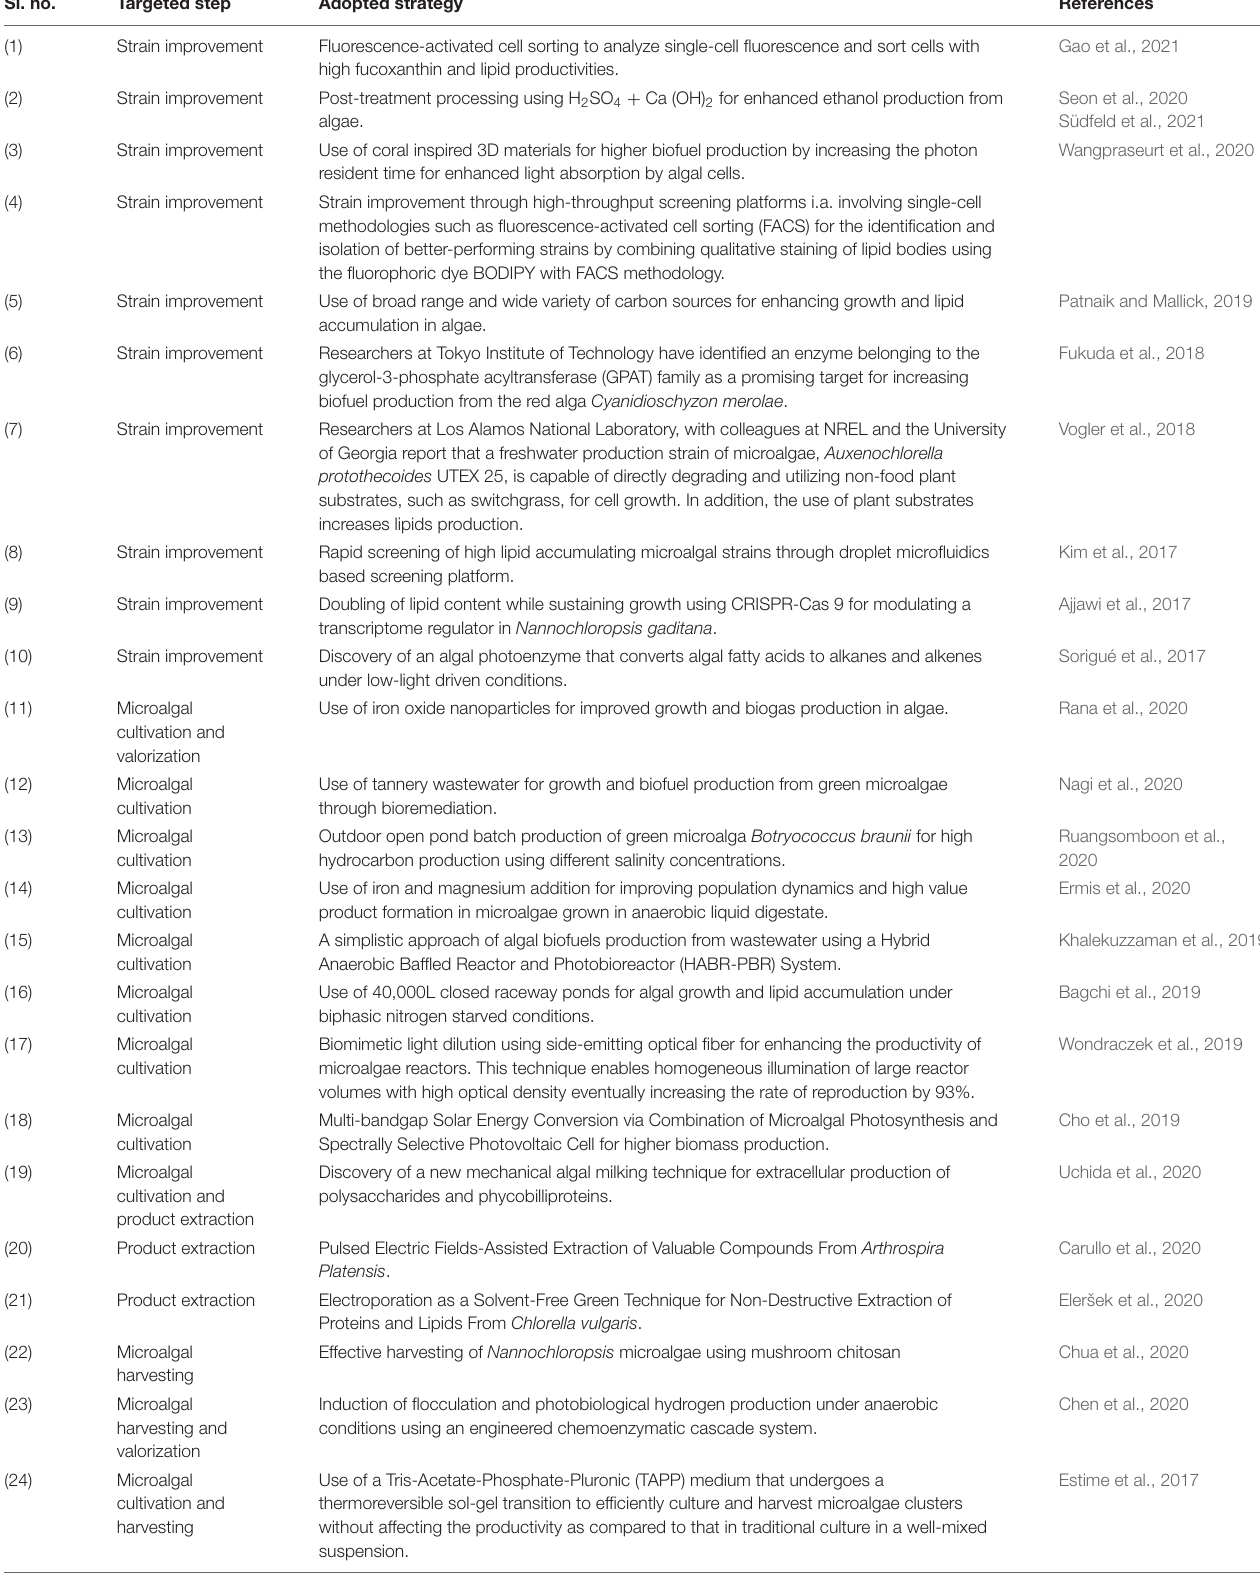
TABLE 3 | Research efforts in the last 5 years with an anticipation to reduce the final selling price of microalgal biodiesel. Sl.